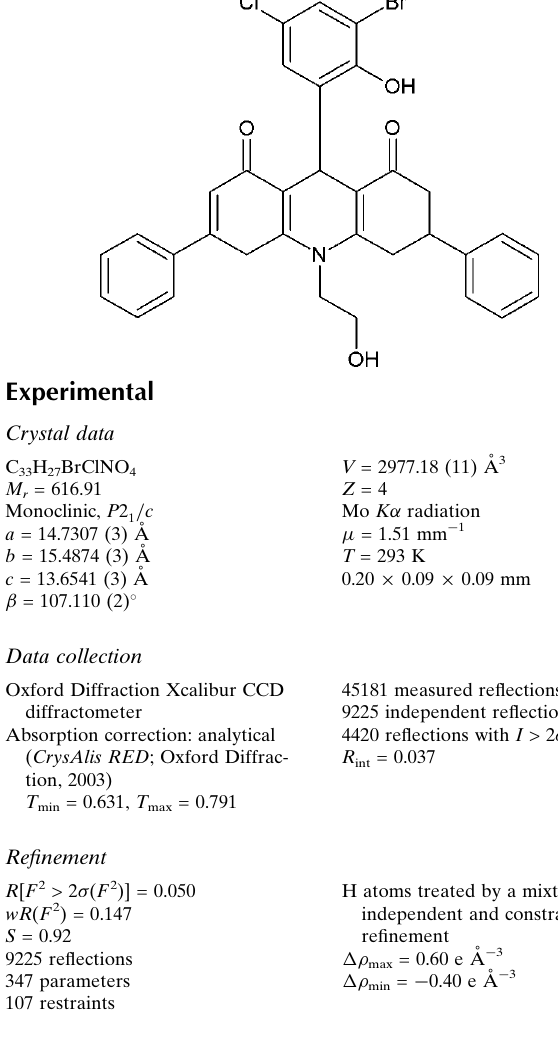
Data collection Oxford Diffraction Xcalibur CCD diffractometer